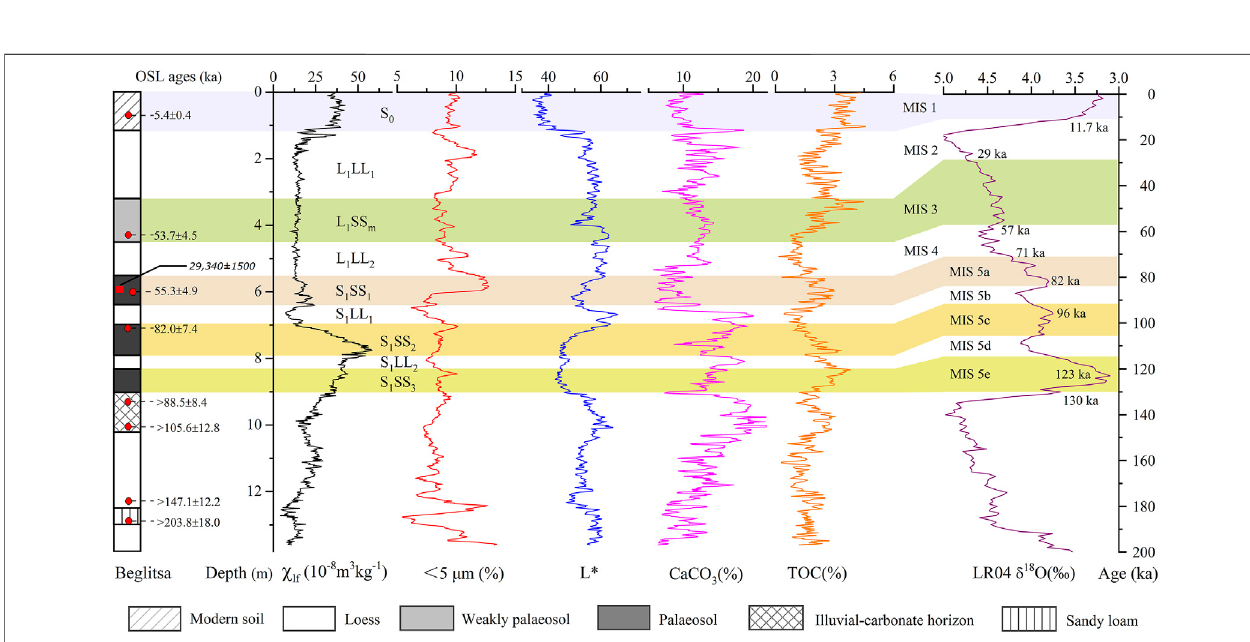
FIGURE 6 | Re fi ned chronostratigraphy of the Beglitsa section with published luminescence and radiocarbon ages, together with multiple climate proxies (the χ lf , < 5 μ m, L*, CaCO 3 %, and TOC), and its correlation with benthic LR04 stack records from Lisiecki and Raymo (2005). Note that optically stimulated luminescence (OSL) and radiocarbon ages obtained by different researchers are illustrated with different forms: the red solid rectangle indicating radiocarbon age is derived from Velichko et al. (2017), and the red solid circles indicating luminescence ages are derived from Chen et al. (2018a).